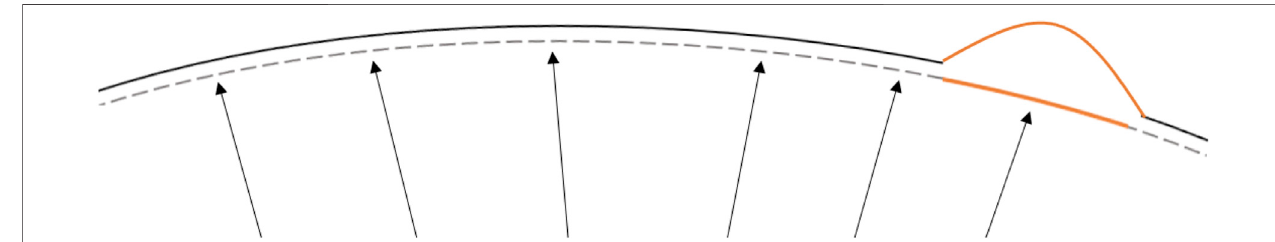
FIGURE1| Schematicrepresentationoflocalisedcornealsoftening(orange)thatunderthesameintraocularpressureloadwoulddeformingreaterextentthanthe surrounding stiffer areas leading to the characteristic corneal ectatic bulging. The dashed line represents the corneal stress-free state. The arrows, a schematic representation of the intraocular ocular pressure and the continuous line the deformed state induced by the intraocular pressure.